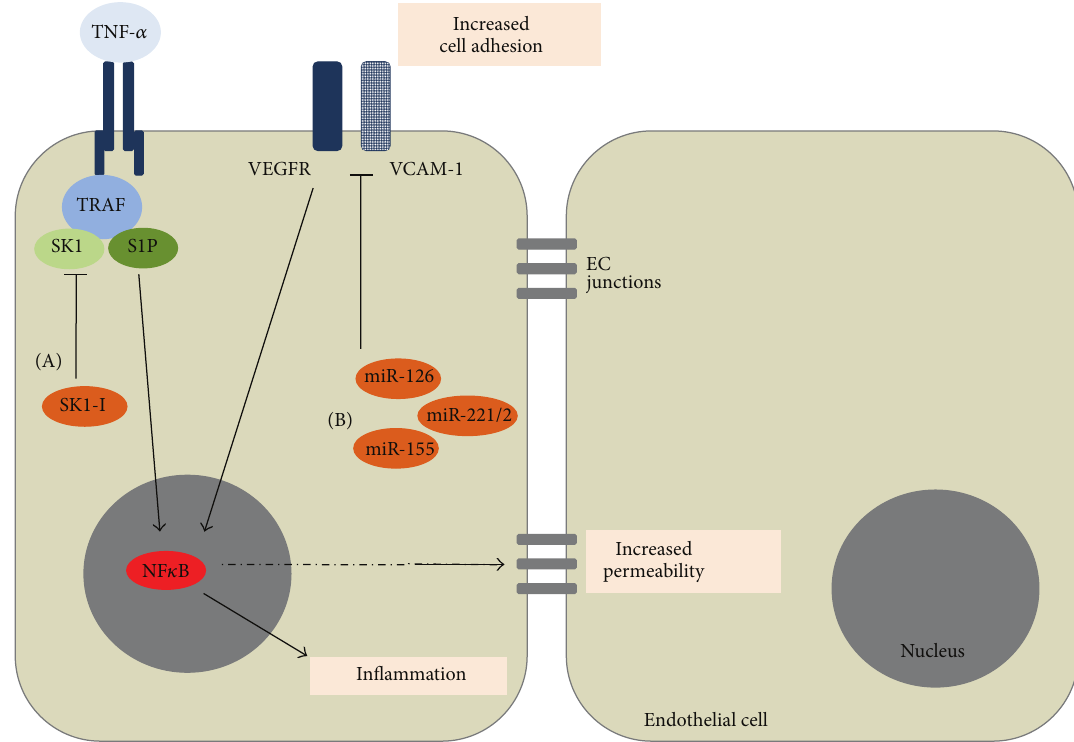
Figure 1: TNF- 𝛼 or VEGF-mediated NF 𝜅 B activation promotes inflammation and opening up of EC junctions leading to increased vascular permeability. Increased VCAM-1 is associated with altered EC function and recruitment of immune cells. We propose (A) Inhibition of SK1. (B) Increased miRNA levels will reduce TNF- 𝛼 or VEGF-mediated NF 𝜅 B activation and reduce VCAM-1 expression leading to maintenance or improvement of vascular